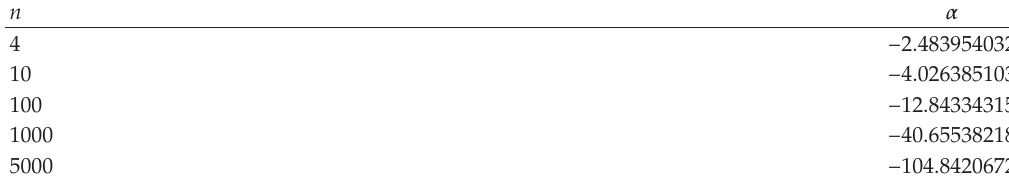
Table 3: Numerical values for α (cid:9) f (cid:6)(cid:6) (cid:3) 0 (cid:4) for n > 1 by using diagonal Pad´e approximants (cid:6) 51 (cid:7)